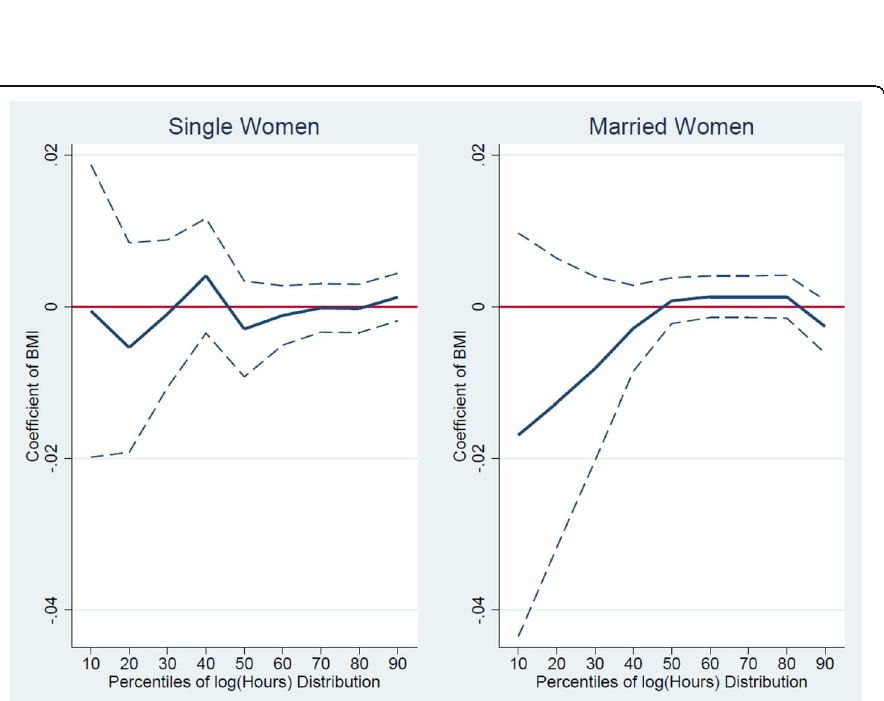
Fig. 4 BMI and log hours of work for Hispanic women: unconditional quantile regression estimates (with 95% confidence interval). Note: Control variables include work experience (quadratic), educational categories, dummies for whether the woman believes in traditional gender roles, whether the respondent has any children, if the youngest child is below six, yearly age dummies, region of residence dummies, and year dummies. For the married sample, additional controls include spouse ’ s age, educational categories, and annual